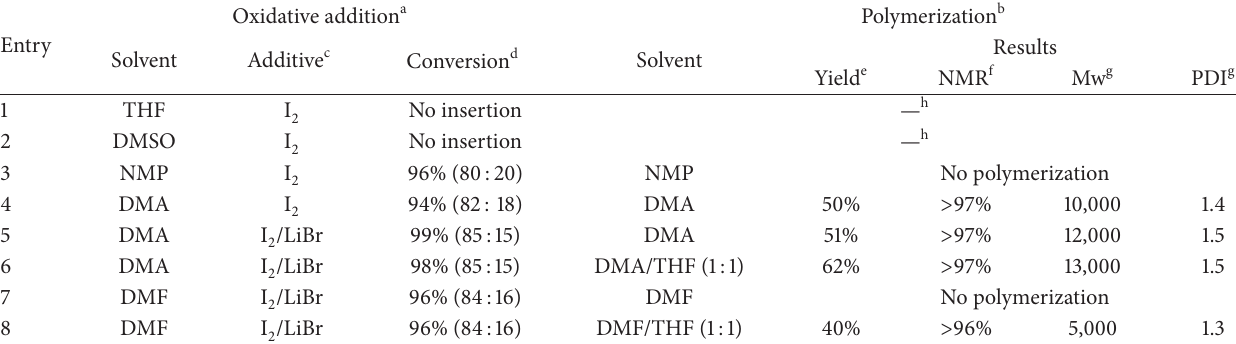
Table 1: Summary of the study.